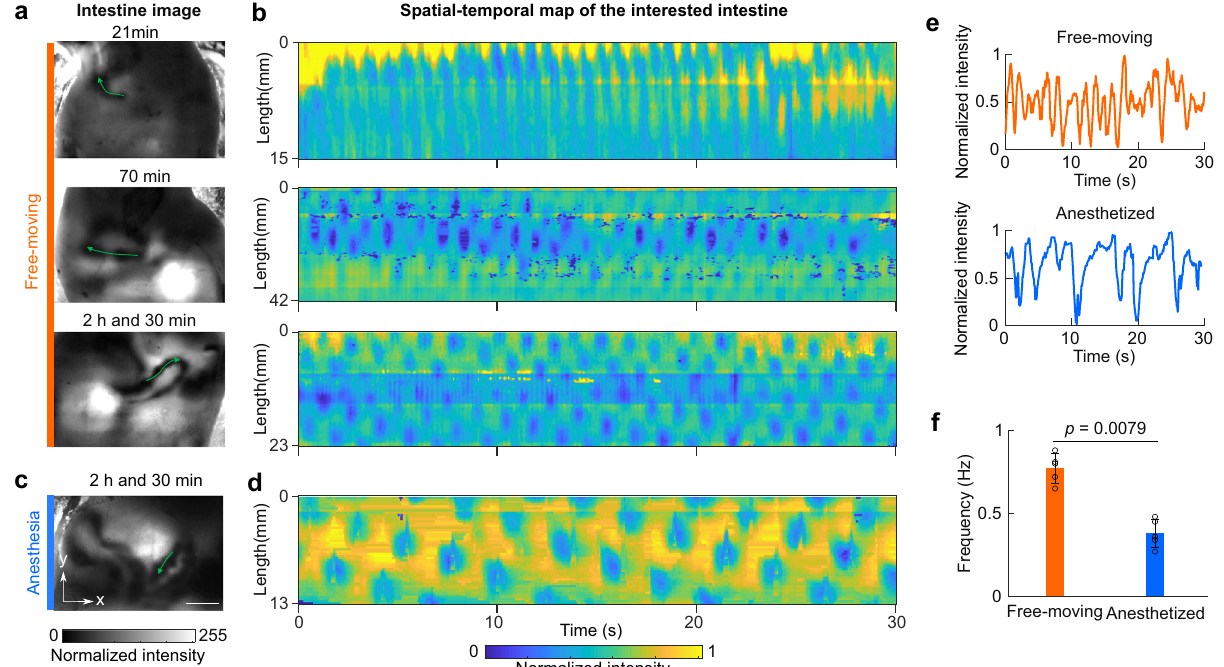
Fig. 2 2D-TIP imaging of intestinal motility in free-moving and anesthetized mice. a Temporal intestinal images of a free-moving mouse. b Spatial- temporal maps of the intestinal region labeled with green arrows in ( a ), (Supplementary Videos 1, 2, and 3). c Intestinal images of an anesthetized mouse (green arrow shows the intestinal region of interest). d Spatial-temporal map of the interested intestine in ( c ) (Supplementary Video 4). Scale bar: 10 mm. e The average intensity of the intestinal cross-sectional pro fi le shows segmentation frequencies of free-moving and anesthetized mice. f Frequency analysis reveals that the intestinal segmentation in free-moving mice occurred at a faster rate than that of the anesthetized mice (mean ± s.d., n = 5 mice, two-sided Wilcoxon rank-sum